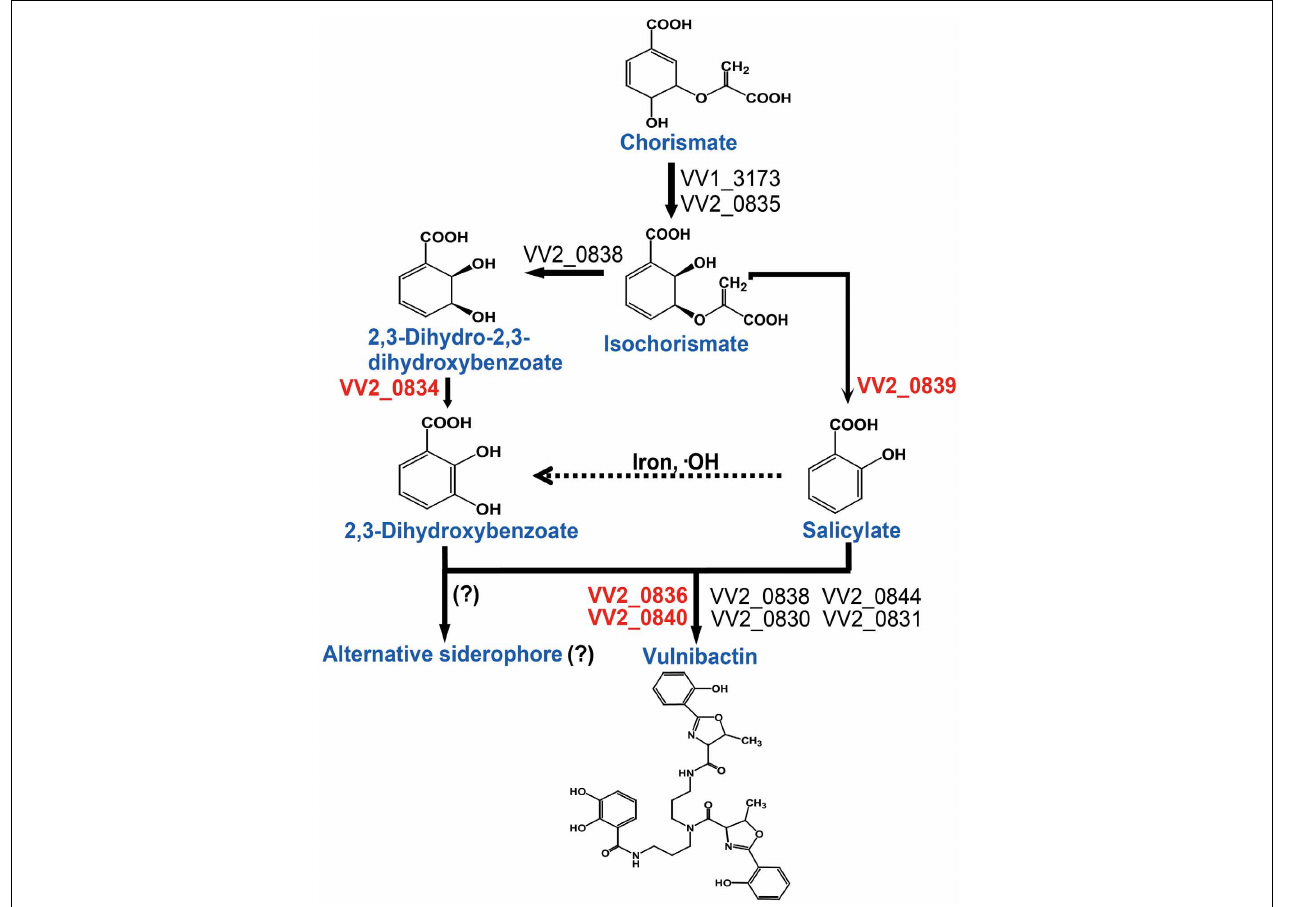
FIGURE 6 | Proposed vulnibactin biosynthesis pathway in V. vulnificus. 2, 3-DHBA and SA are synthesized from the common precursor chorismate and are activated by AMP ligases encoded by VV2_0836 and VV2_0840 for siderophore assembly. In presence of iron and hydroxyl radicals SA can be